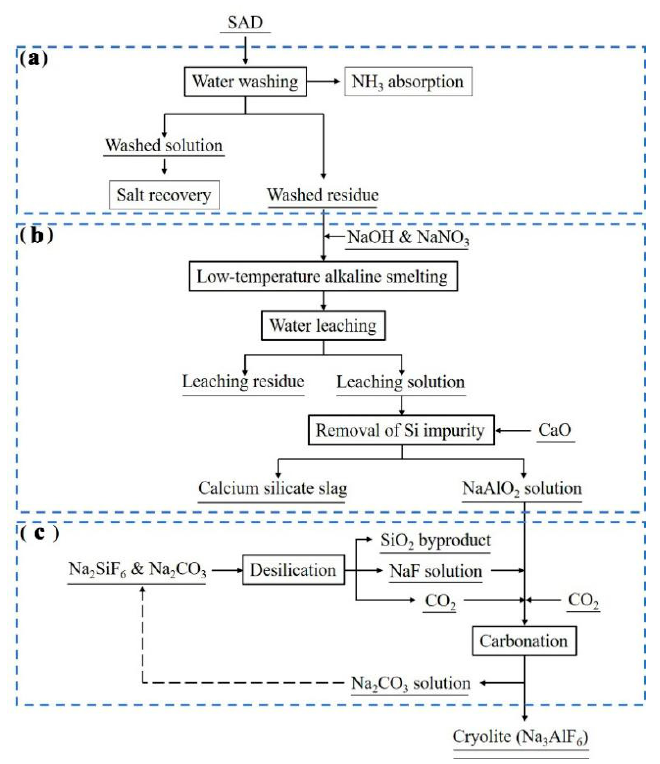
Figure 1. Flowchart for the synthesis of cryolite from secondary aluminum dross (SAD): water-washing pretreatment of SAD ( a ), extraction of Al component via pyro-hydrometallurgical process ( b ), and carbonation ( c ).